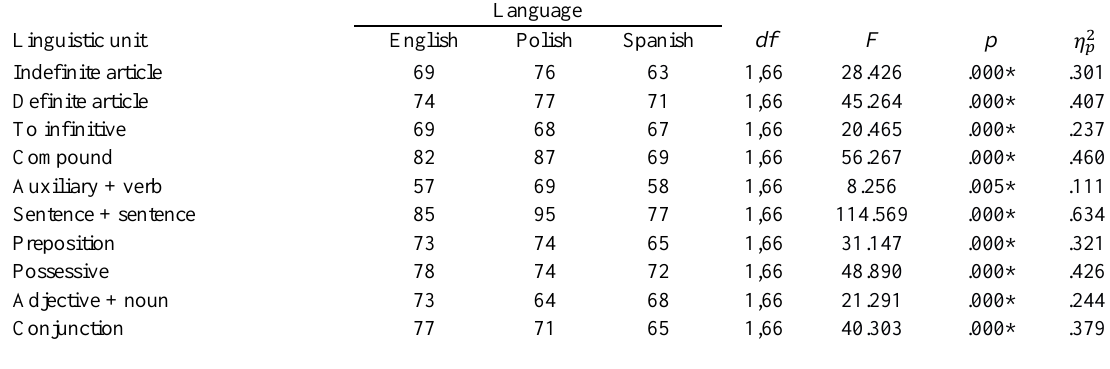
Table 3. Percentage of participants who preferred the syntactically segmented